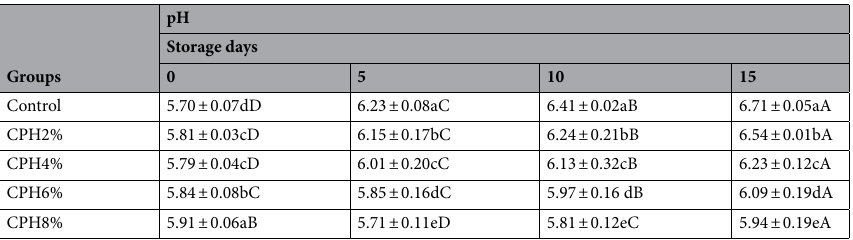
Table 6. pH of casein protein hydrolysate (CPH) powder incorporated raw beef nuggets. CPH: casein protein hydrolysate. All the values are means of triplicate determinations ± Standard Deviation (SD). Means within the column with different small letters are significantly different (p < 0.05) and different capital letters within the row differed